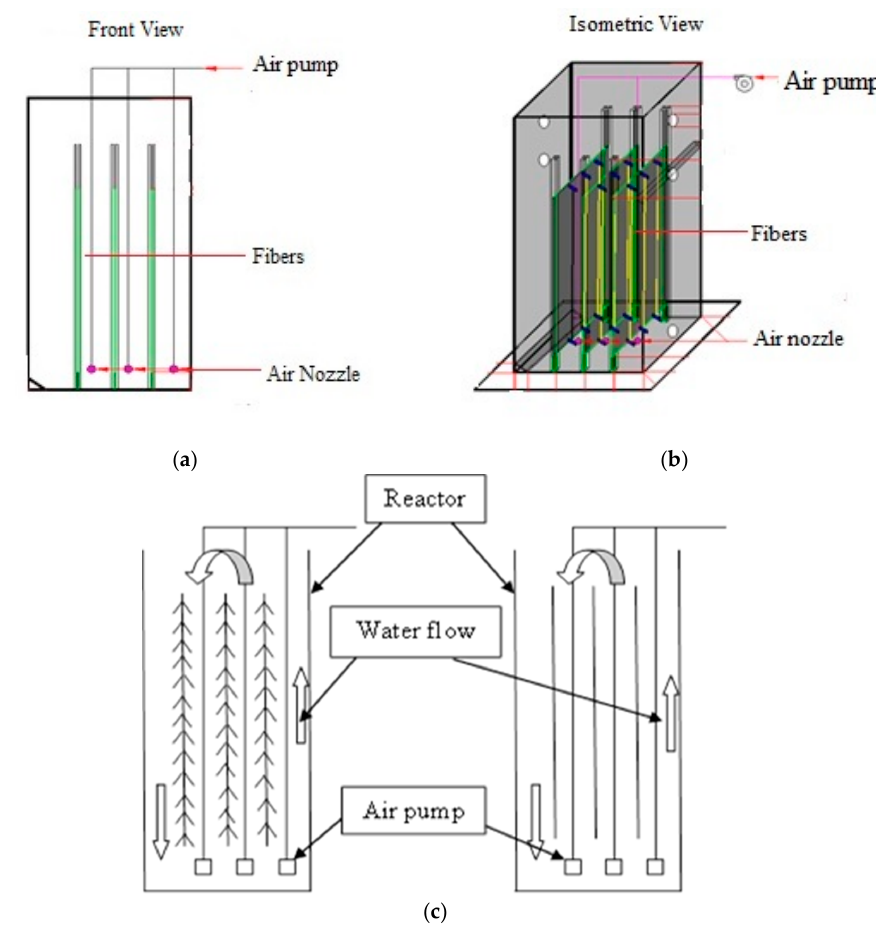
Figure 1. Schematic drawing of SBR reactor ( a ) Front view; ( b ) Isometric view; ( c ) Full details. Table 3. Summary of operating design